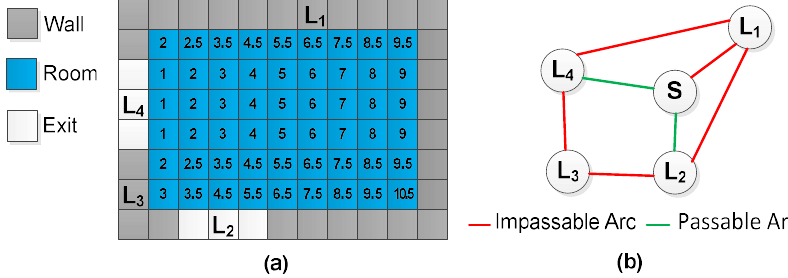
Figure 2. Environment modeling with the Grid Object and Agent Model (GOAM): ( a ) a spatial environment with a room (Node S), walls (Nodes L 1 and L 3 ) and exits (Nodes L 2 and L 4 ). The numbers show the distance weights between node L 4 and node S; ( b ) the grid object network of the environment.